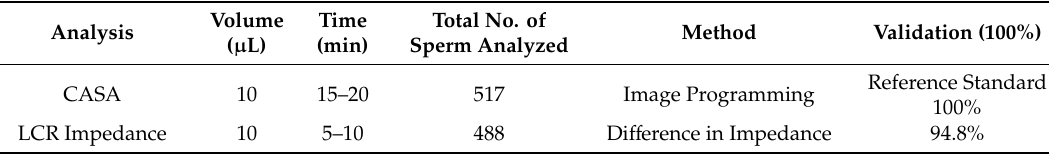
Table 3. Comparison between CASA and liquidity coverage ratio (LCR) impedance for spermatozoa detection and